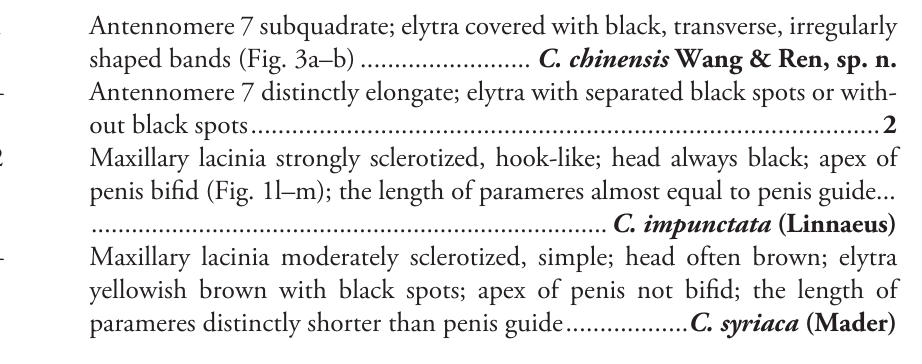
Cynegetis chinensis Wang & Ren, sp. n.